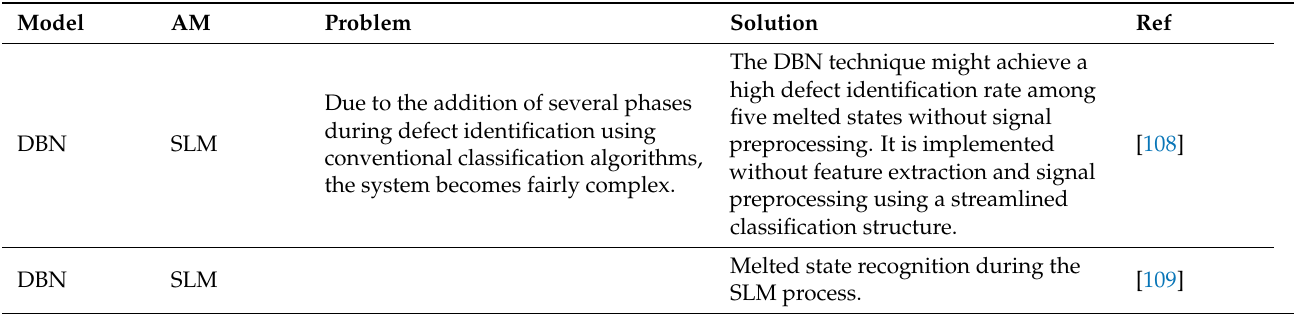
Table 7. Summary of various literature on